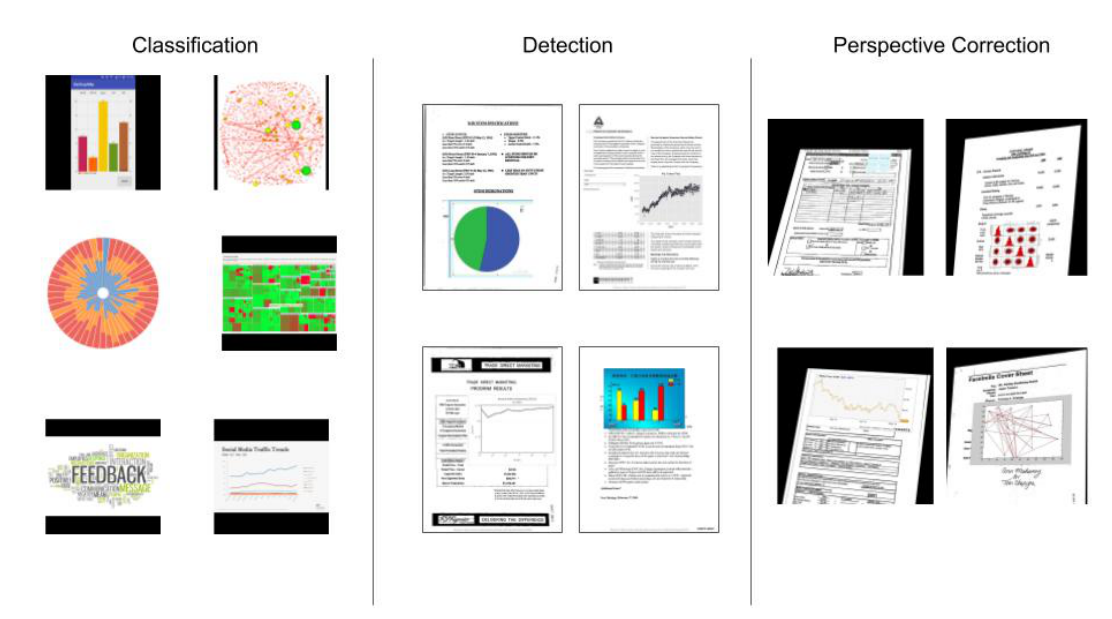
Figure 4. Samples of three datasets for the experiments (from left to right): classification, with added chart images; detection, with chart overlaying document images; and, perspective correction, with distorted